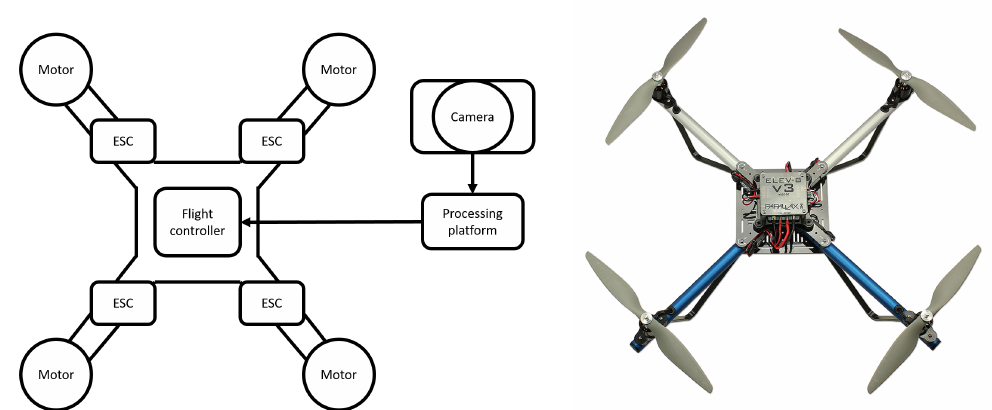
Figure 2. The main components of a drone: Flight controller, ESC (Electronic Speed Controller) and motors. We added an extra camera and processing platform to our